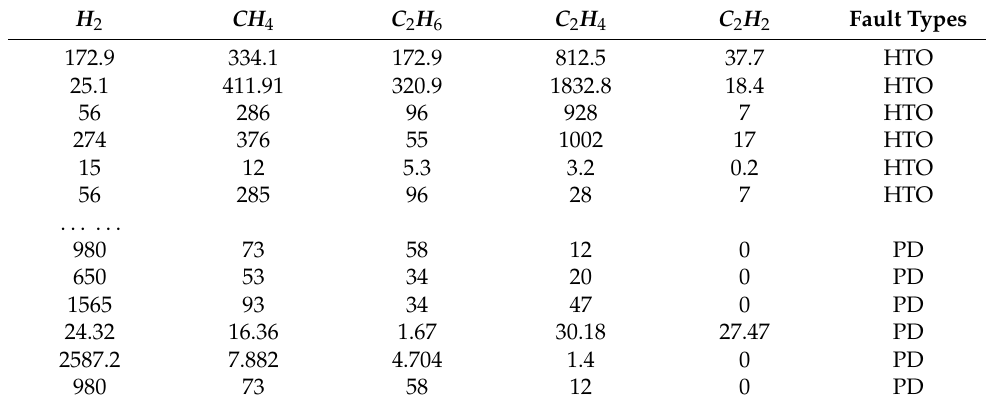
Table 7. The codes of transformer fault types.